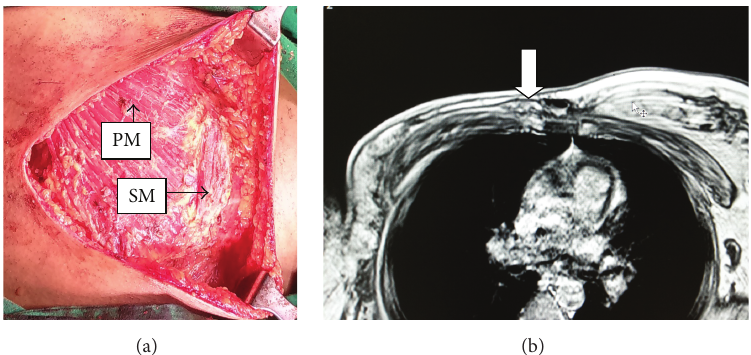
Figure 1: (a) Intraoperative photograph showing a thin fleshy ribbonlike muscle of size approximately 10cm × 3 cm present in the right parasternal region perpendicular to fibres of the pectoralis major muscle. PM: pectoralis major, SM: sternalis muscle. (b) MRI of anterior chest wall (post-MRM) showing a unilateral sternalis muscle (white arrow) in transverse